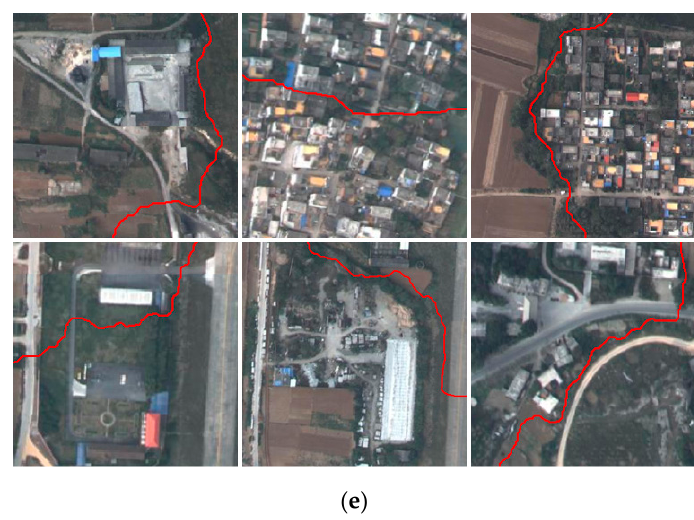
Figure 11. Experimental results of image mosaicking: ( a ) the remote sensing image set; ( b ) positional relations and overlapping regions; ( c ) seamlines in two-image overlap; ( d ) optimal seamlines; ( e ) the details of yellow rectangles in ( d ). Table 2. Comparison of seamlines.